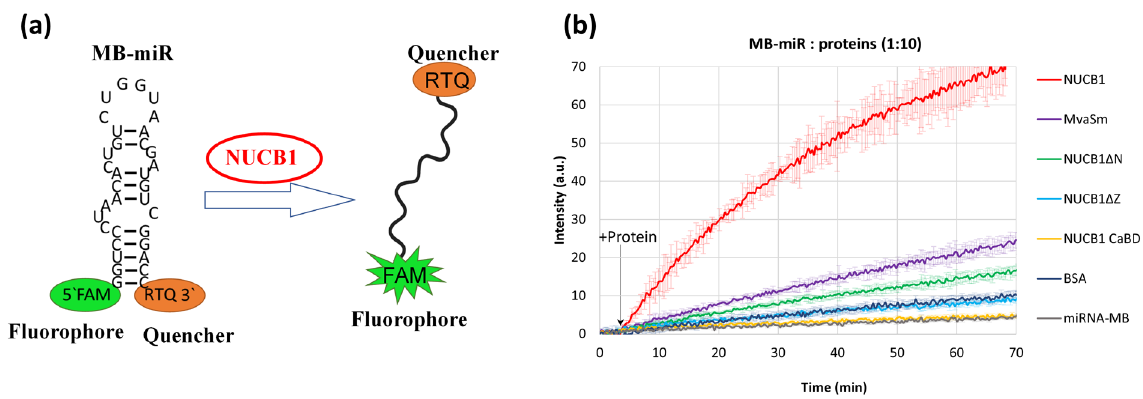
Figure 4. Molecular beacon melting assay. ( a ) Scheme of the MB-miR melting experiment. ( b ) Melting curves of MB-miR alone (grey curve) or after addition of proteins (colored curves). Error bars for each curve indicate the standard deviation.